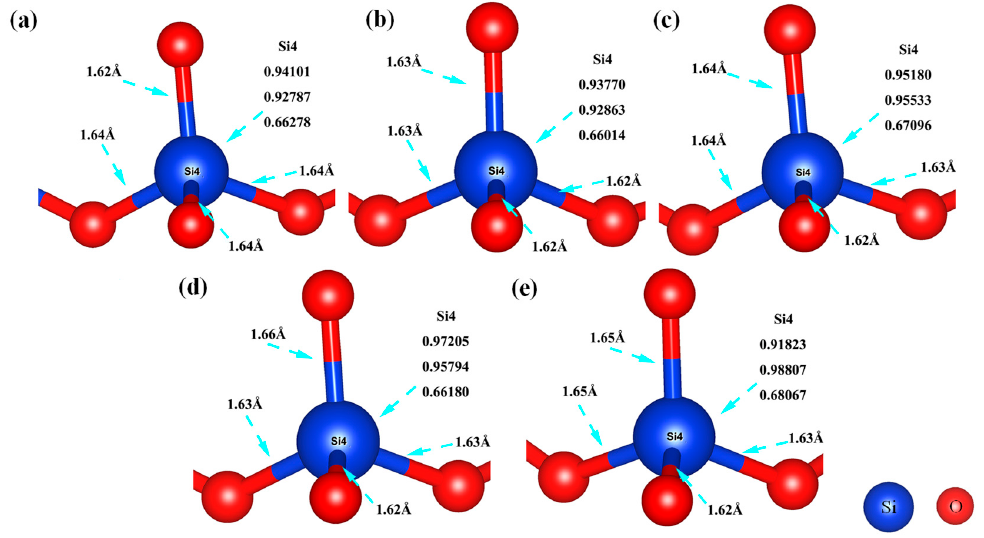
Figure 8. The microstructure evolution of the Si − O units in kaolinite: ( a )Sim − Ka; ( b ) Phase 1; ( c ) Phase 2; ( d ) Phase 3; ( e ) Phase